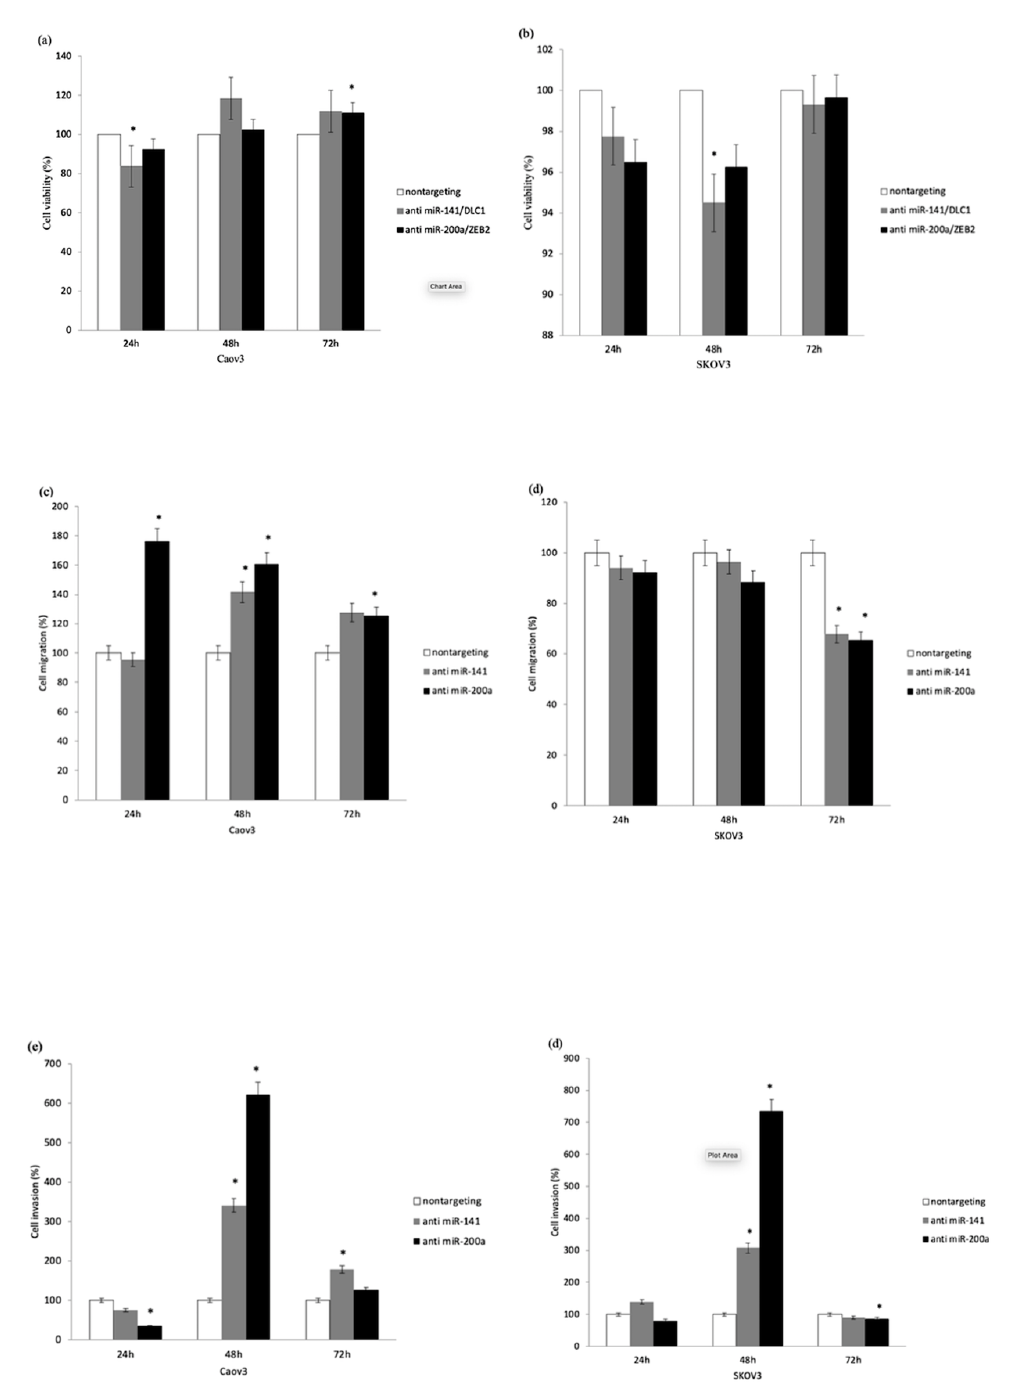
Figure 5. Functional assays performed on Caov3 and SKOV3 cells. ( a ) MiR-141 inhibition in Caov3 and ( b ) SKOV3 cells caused a significant reduction in cell viability after 24 h and 48 h, respectively. Anti-miR-200a treatment did not cause a reduction in cell viability in both cell lines. ( c ) In Caov3 cells, treatment with anti-miR-141 caused enhanced cell migration significantly after 48 h, while anti-miR-200a treatment led to the highest increase in cell migration after 24 h. ( d ) Increased cell migration, however, was not observed in SKOV3 cells treated with miRNA inhibitors. ( e , f ) MiR-141 and miR-200a inhibition in both cell lines led to the highest significant increase in cell invasion after 48 h. Statistical analysis was performed using a student’s t -test. The graph represents the mean ± standard error of duplicate experiments. * p < 0.05.